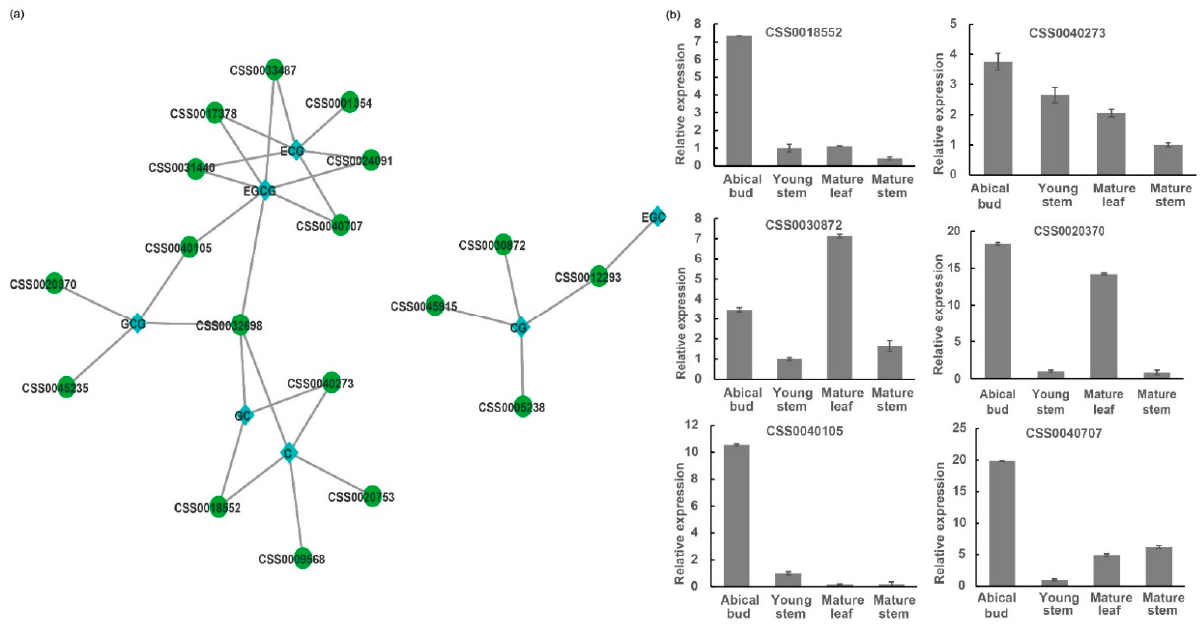
Figure 8. Correlation analysis and gene expression validation of catechins accumulation-related CsC2H2-ZFPs . ( a ), corre- lation network of CsC2H2-ZFP genes and catechins content; ( b ), Relative gene expression of candidate CsC2H2-ZFPs by qRT-PCR. The node color indicates the different metabolites or genes in the figure. The green nodes are CsC2H2-ZFP genes and blue nodes are metabolites. CsC2H2-ZFPs and catechins correlations with R 2 > 0.9 are represented as links between nodes ( p < 0.05). 18s rRNA was used as the internal control for normalization and relative expression levels were calculated using the 2 ( −∆∆ Ct) method; error bars represent the standard deviations from three biological replicates.